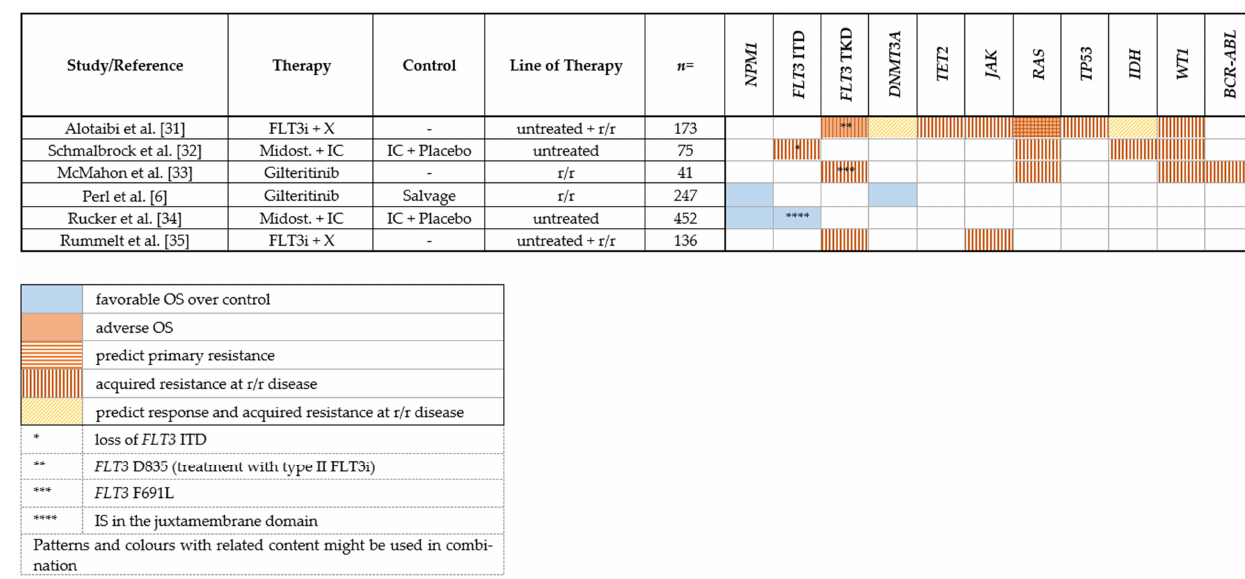
Table 1. Mutations associated with response or resistance to FLT3